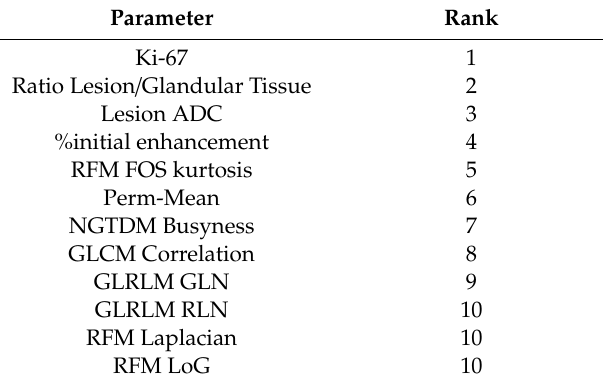
Table 3. The ranking of single radiomic features by IRIS.